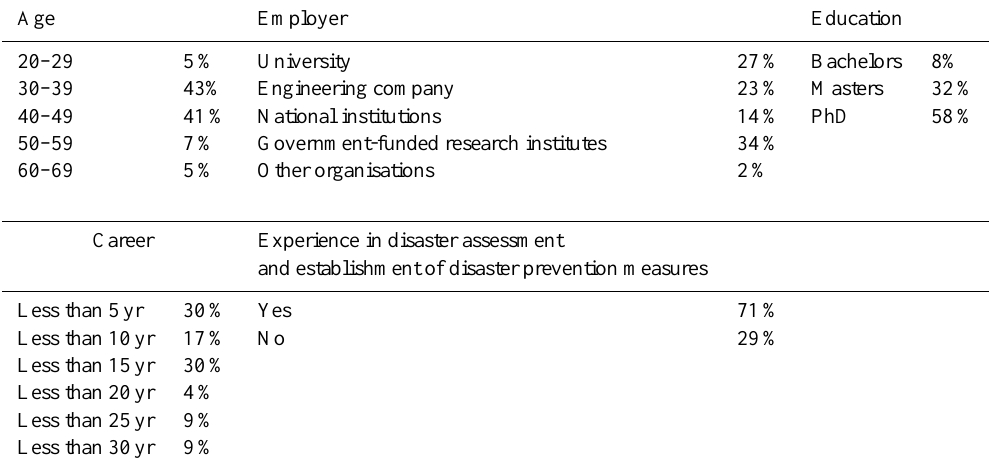
Table 2. Basic information on the